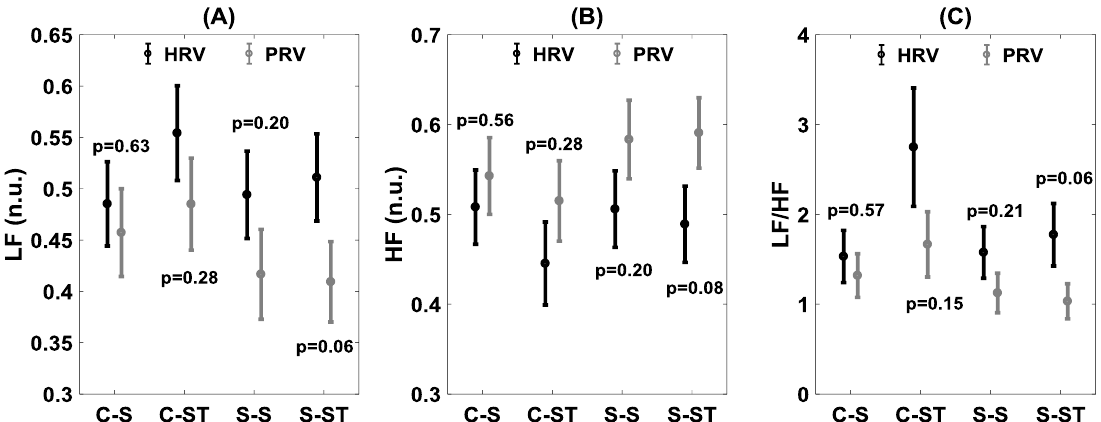
Figure 6. Statistical comparison of HRV and PRV for the two groups (control / stroke) and the two conditions (sit / stand) for normalized LF ( A ), normalized HF ( B ), LF / HF ratio ( C ). The figure represents the distribution (mean ± SE) in control–sit (C–S), control–stand (C–ST), stroke–sit (S–S), and stroke–stand (S–ST). The figure also lists the statistical p -value of the comparison.